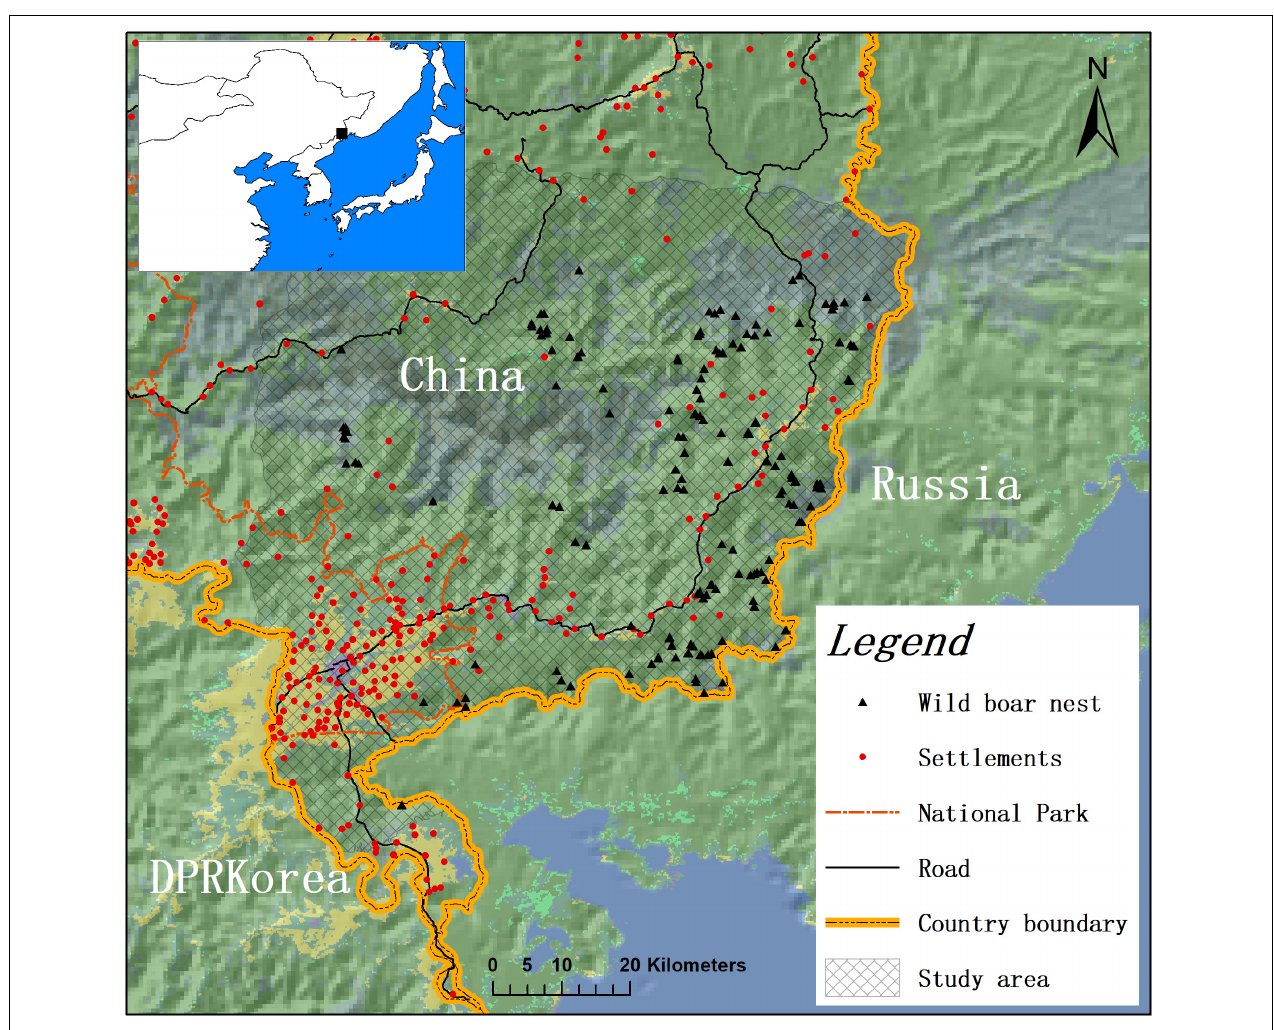
FIGURE 1 | Schematic diagram of the location of the study